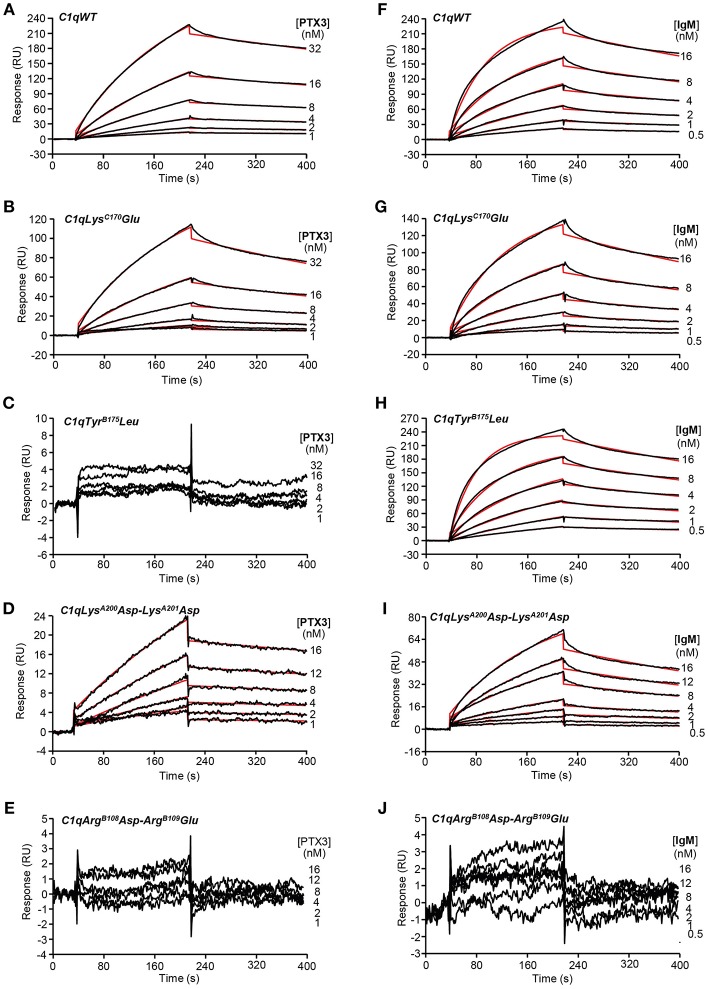
Kinetic analyses of the interaction of PTX3 and IgM with immobilized C1q variants. Sixty microliter of PTX3 at the indicated concentrations were injected over (A) C1qWT (16,300 RU), (B) C1qLysC170Glu (17,000 RU), (C) C1qTyrB175Leu (12,200 RU), (D) C1qLysA200Asp-LysA201Asp (18,400 RU), and (E) C1qArgB108Asp-ArgB109Glu (17,500 RU) in 50 mM Tris-HCl, 150 mM NaCl, 2 mM CaCl2, 0.005% surfactant P20, pH 7.4 at a flow rate of 20 μl/min. (F–J) IgM was injected over the immobilized C1q variants under the same conditions as in (A–E). The binding signals shown were obtained by subtracting the signal over the BSA reference surface and further subtraction of buffer blanks. Fits are shown as red lines and were obtained by global fitting of the data using a 1:1 Langmuir binding model. Chi2 values were between 0.25 and 5.8. Each kinetic analysis shown is representative of two to five independent experiments performed on separate sensor chips.